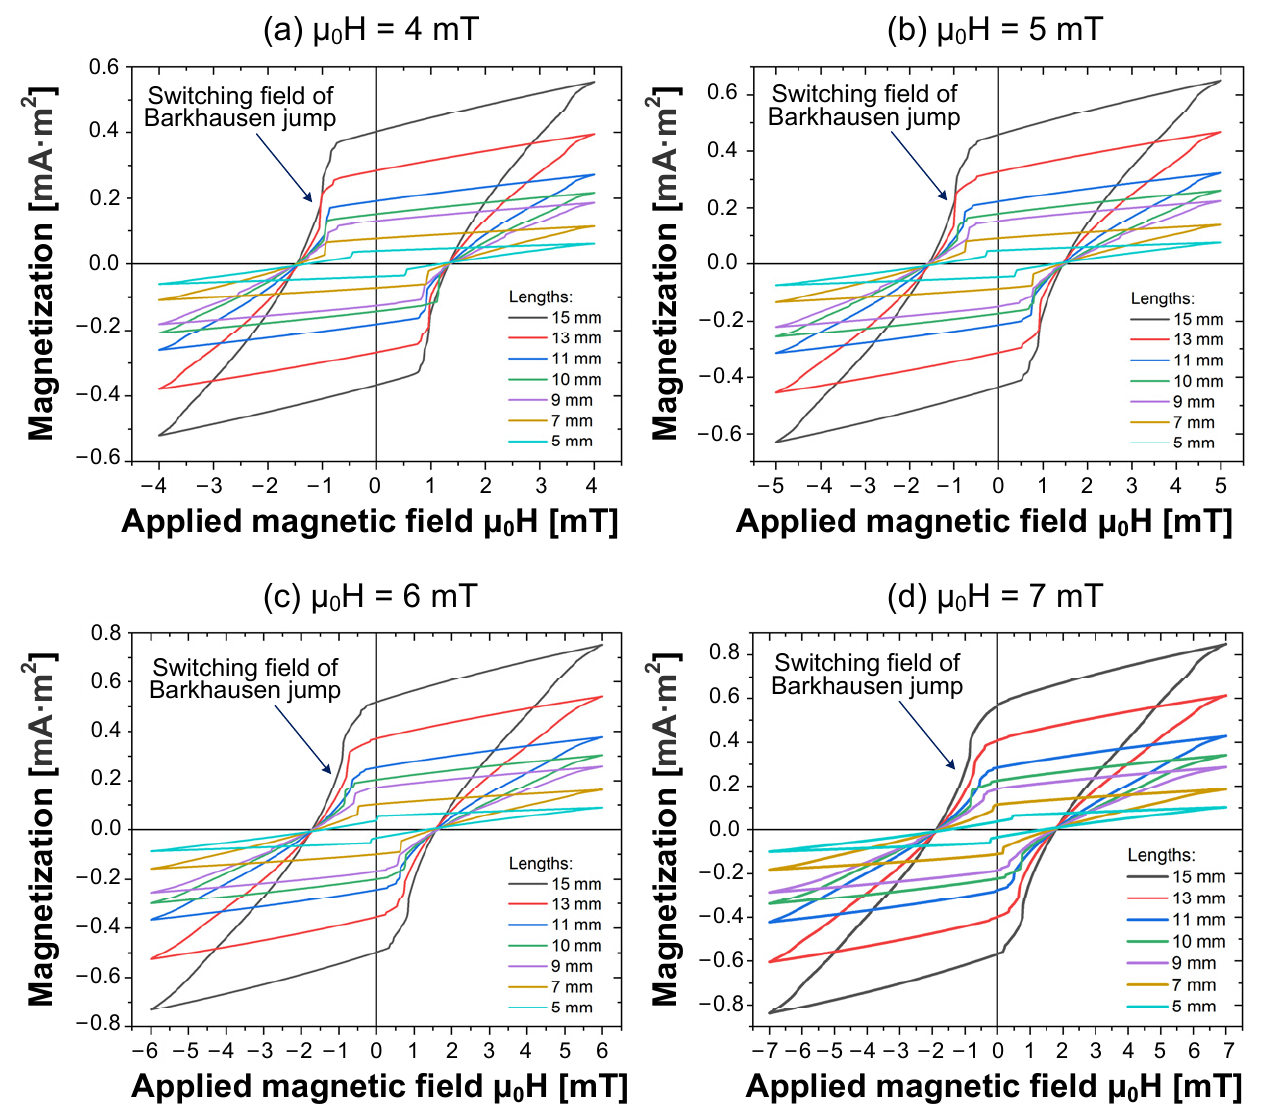
Figure 7. Magnetization curves (minor loops) of Wiegand wires at various lengths and at a diameter of 0.25 mm. Applied magnetic field intensities at ( a ) µ 0 H = 4 mT; ( b ) µ 0 H = 5 mT; ( c ) µ 0 H = 6 mT; and ( d ) µ 0 H = 7 mT.